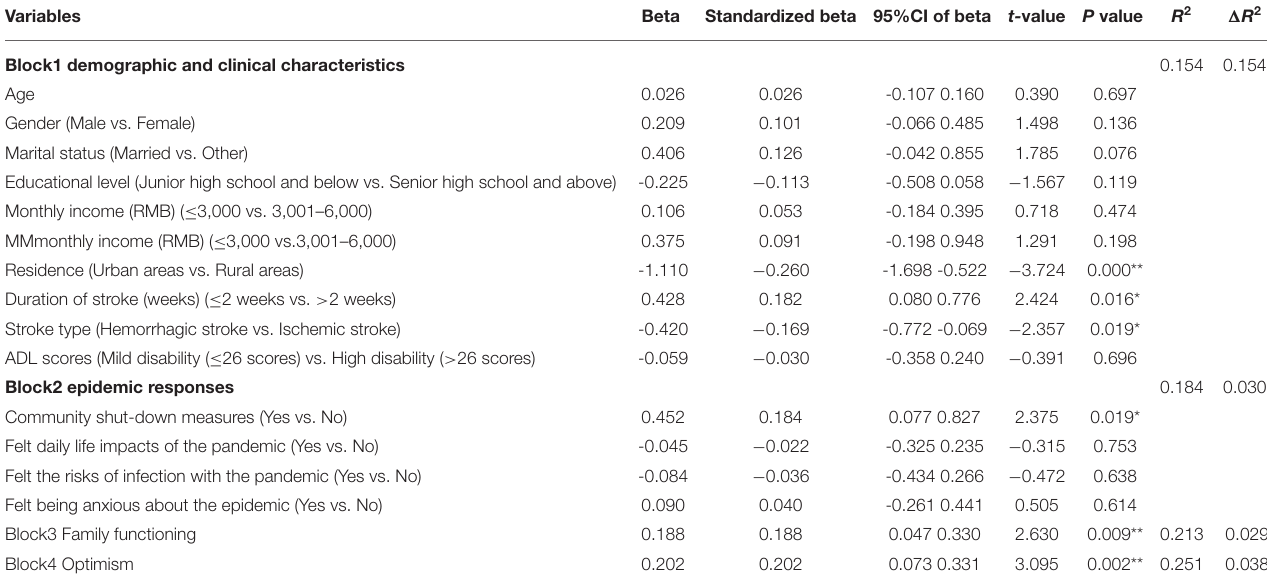
TABLE 3 | The hierarchical regression analysis of life satisfaction ( N =